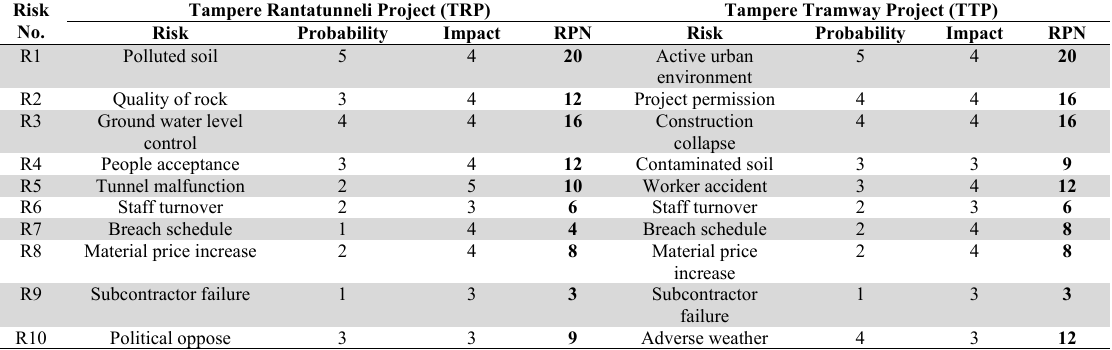
Risk Severity Calculation of TRP and TTP Risk